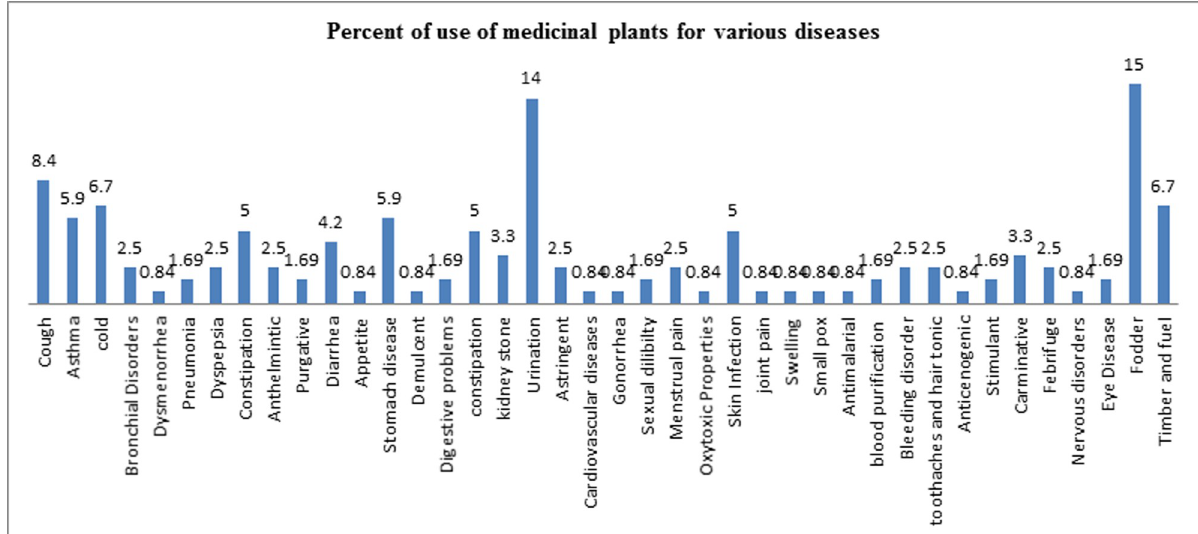
Fig 5. Multipurpose uses of native plants for domestic and medicinal